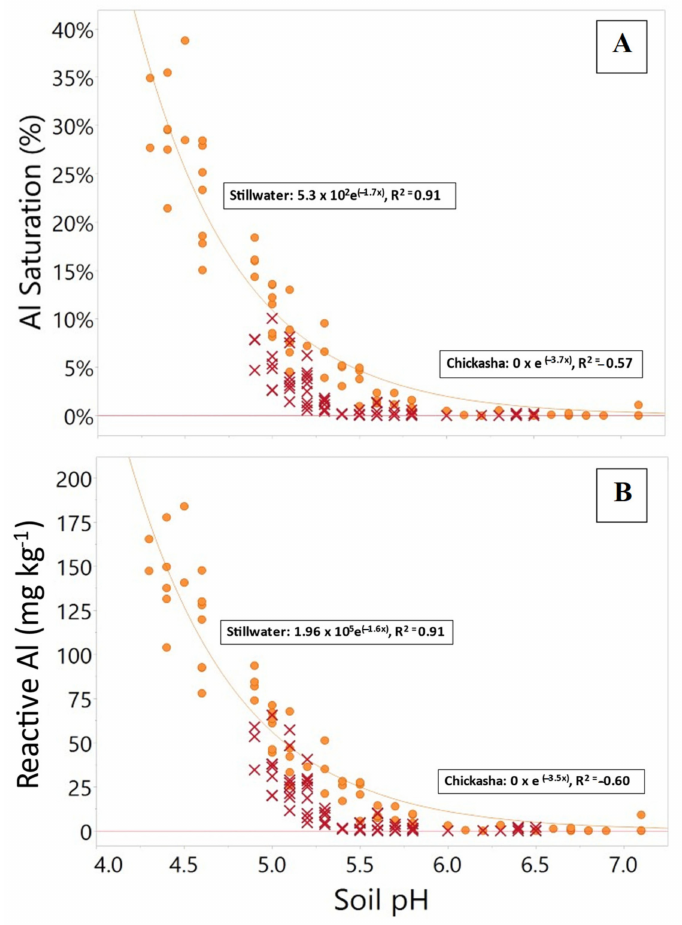
Figure 1. The Easpur loam soil at Stillwater indicated a significant relationship involving soil pH and Al concentrations. However, Chickasha did not exhibit the significant exponential relationship between soil pH and Al sat /Al KCl that would be expected in aluminous acidic soils. ( A ) Relationship between soil pH and Al saturation (Al sat ) at Stillwater (circles) ( p < 0.0001) and Chickasha (marks); ( B ) relationship between soil pH and exchangeable Al (reactive Al) at Stillwater (circles) ( p < 0.0001) and Chickasha (marks). Year 1 and Year 2 combined for each figure (Levene’s test, p > 0.05). Neg- ative R 2 values at Chickasha serve as an indicator of lack of model fit and failure of the model to statistically converge. Stillwater curves redacted from “Closely related winter wheat cultivar performance in U.S. Great Plains acid soils,” by Gillespie et al., 2020, Agronomy Journal,